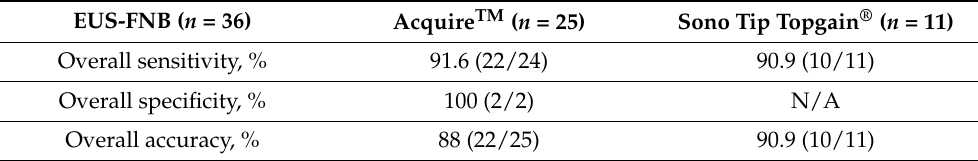
Table 5. The sensitivity, specificity and accuracy of EUS-FNB